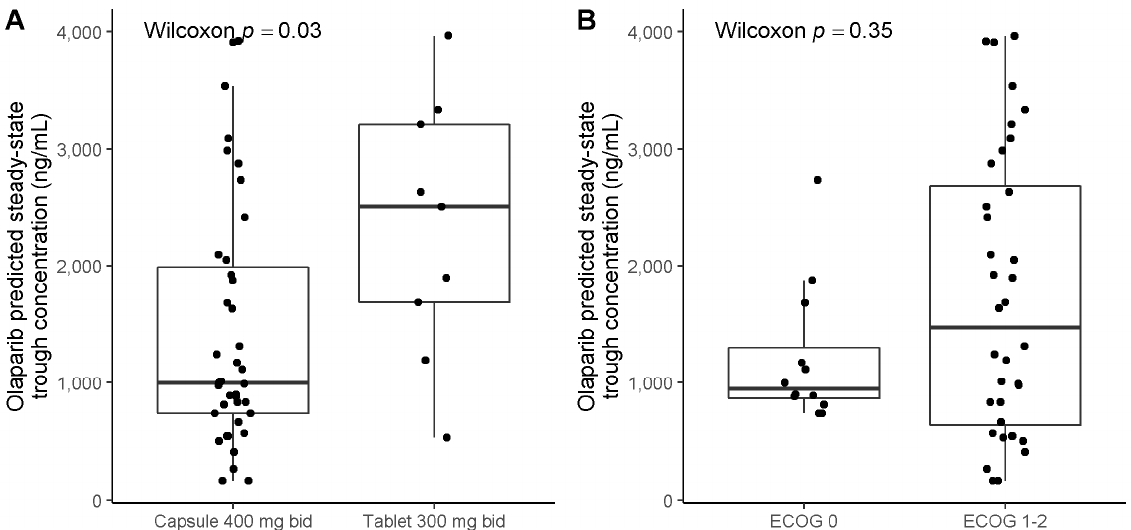
Figure 3. Olaparib steady-state predicted trough concentrations (C minPred ) according to olaparib formulation and ECOG-PS. ( A ) C minPred according to olaparib dose and formulation. ( B ) C minPred according to ECOG-PS. ECOG-PS: Eastern Cooperative Oncology Group Performance Status. Patients included in this analysis are patients treated with the recommended dose.